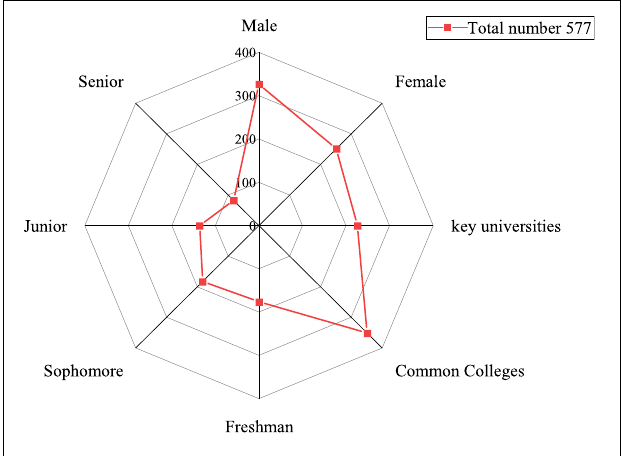
FIGURE 4 | Composition of investigated students.